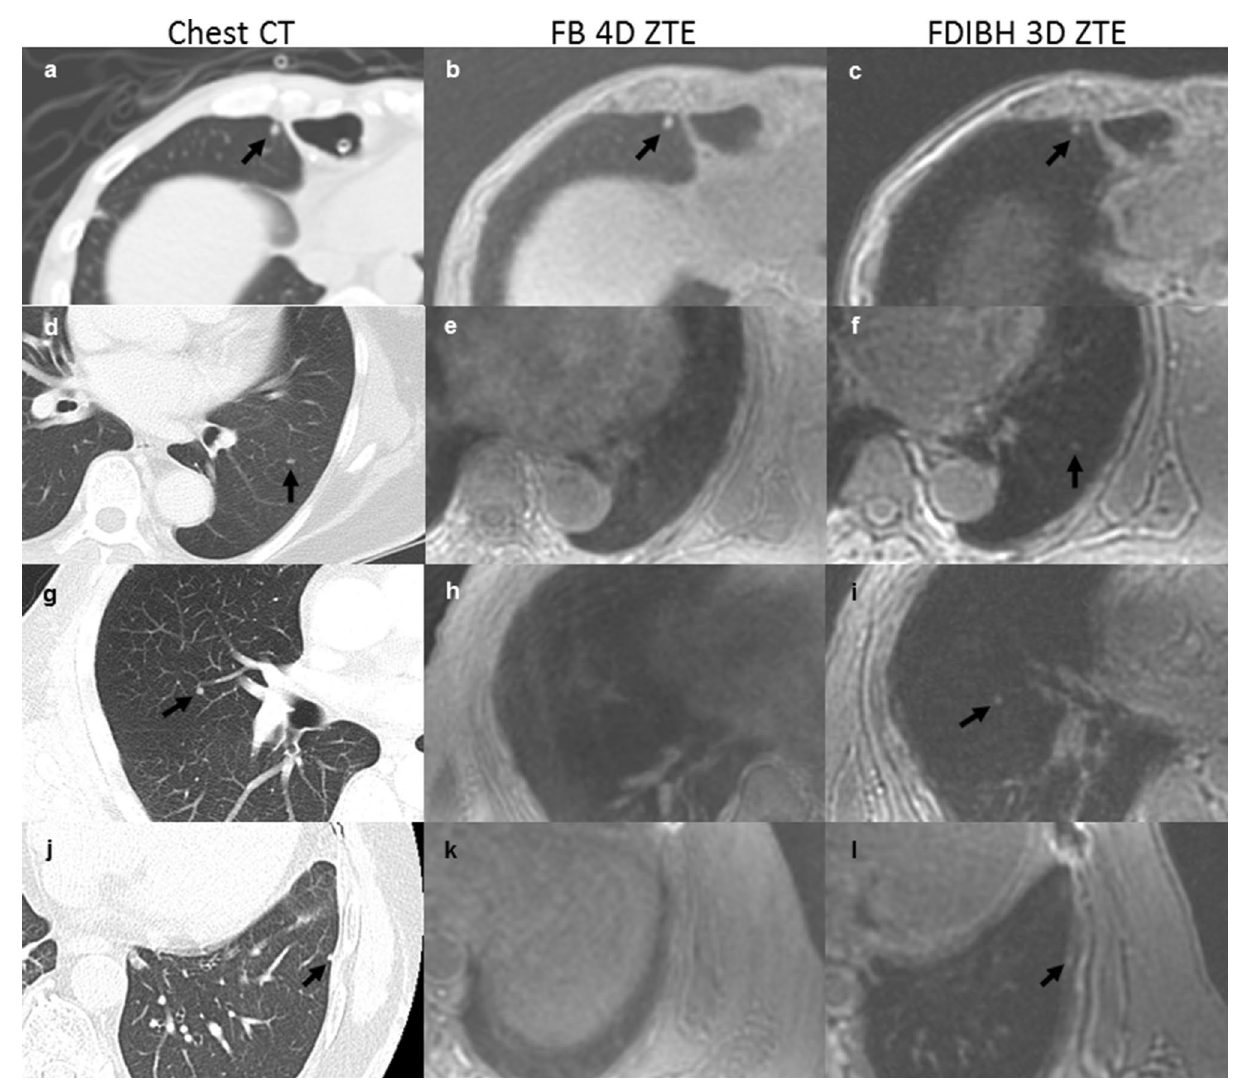
Figure 3. The ZTE detected lung base nodules less than 5 mm in various kinds of cancers. Both the FB 4D ZTE and the FDIBH 3D ZTE detected a 4.9 mm right middle lobe nodule ( b , c ) in a 50-year-old male esophageal cancer patient. The FDIBH 3D ZTE outperformed FB 4D ZTE by a 3.5 mm left lower lobe nodule ( f ) in a 64-year-old female patient with both thyroid cancer and lung cancer, a 3.3 mm right middle lobe nodule ( i )